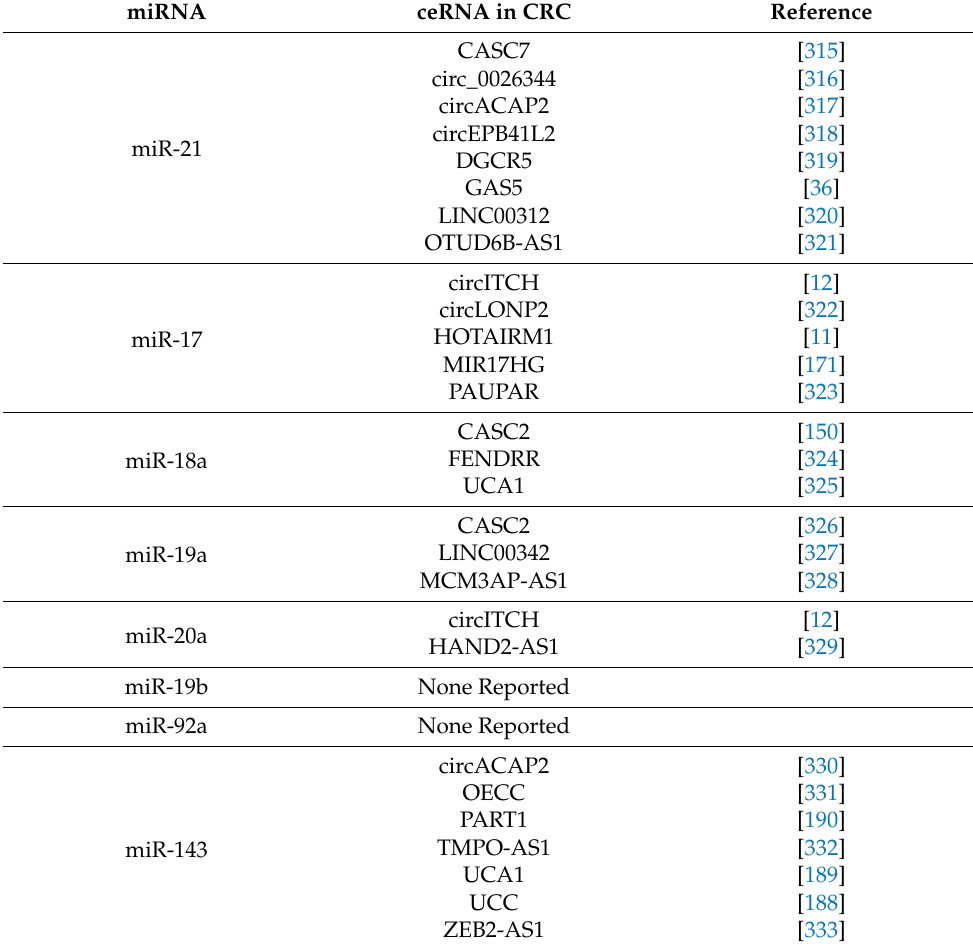
Table 2. Reported ceRNAs and targeted miRNAs in